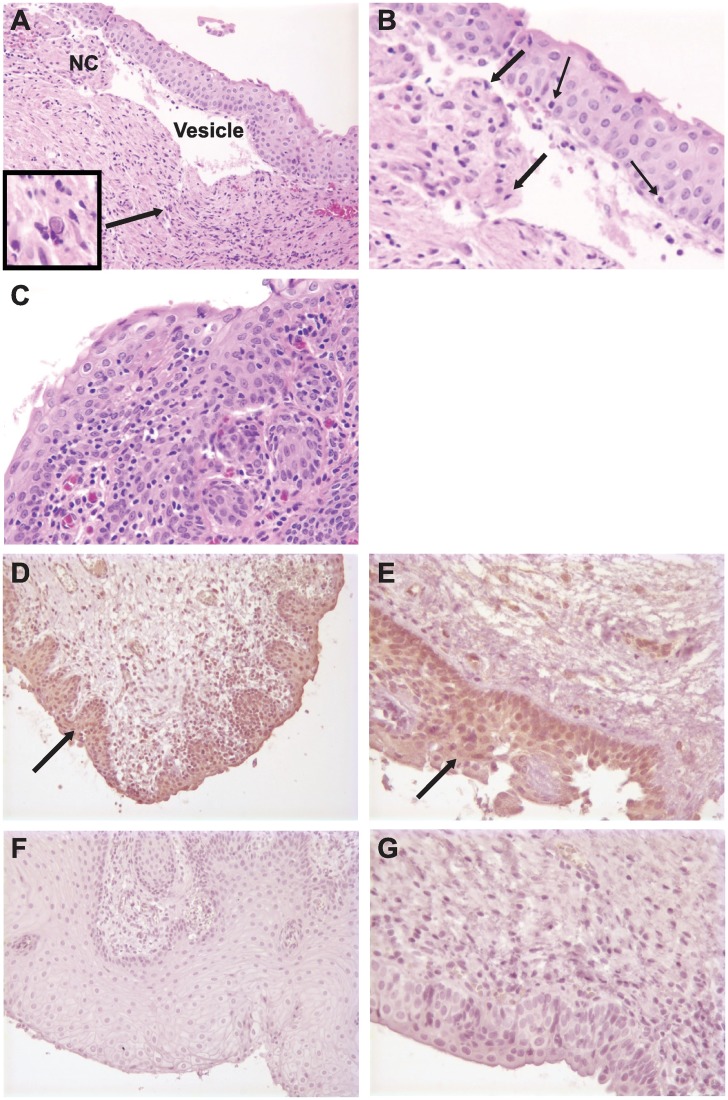
Histopathology and immunohistochemistry of vaginal mucosa in naïve and trivalent immunized rhesus macaques.(A) Histopathology of a naïve animal two weeks after intravaginal infection. An intraepithelial vesicle and necrotic cells (NC) were detected. Magnification 20X. The boxed area shows a magnified view of a typical HSV intranuclear inclusion that is located in the tissue at the tip of the arrow. (B) Computer-generated magnification of the necrotic cells in Fig 5A. Thin arrows indicate hypotonic, clear fluid-filled cytoplasm, while thick arrows identify pyknotic nuclear degeneration. (C) Histopathology of the second naïve animal demonstrating mucosa infiltration of many lymphocytes and plasma cells. Magnification 40X. (D) Immunohistochemistry demonstrating moderately strong HSV-2 antigen staining (arrow) of vaginal biopsy tissues from a naïve animal eight days after the third HSV-2 intravaginal challenge. Magnification 20X. (E) Moderately strong HSV-2 antigen staining (arrow) of another naïve animal taken at the same time as Fig 5D. Magnification 40X. (F) Immunohistochemistry demonstrating no HSV-2 antigen staining of vaginal tissues obtained from a trivalent immunized animal eight days after the third HSV-2 intravaginal challenge. Magnification 20X. (G) Negative staining for HSV-2 antigen in the second animal immunized with the trivalent vaccine taken at the same time as Fig 5F. Magnification 40X.